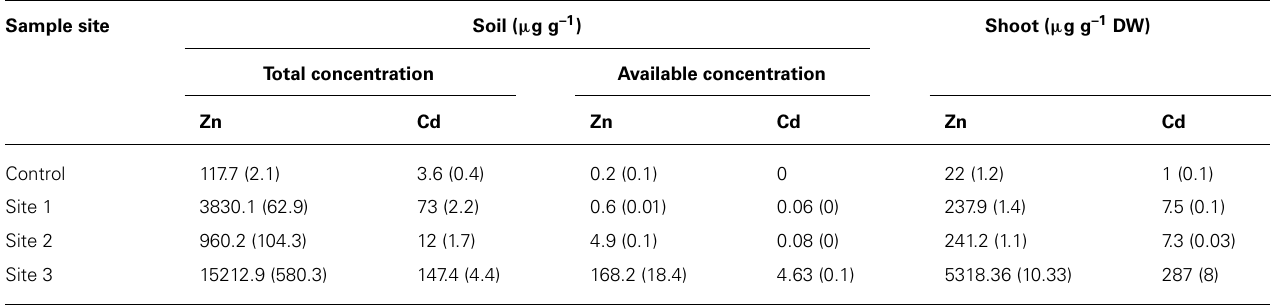
Table 1 | Zinc (Zn) and cadmium (Cd) concentrations ( μ g g –1 ) in soil samples from the Zn smelting area atTrês Marias, MG, Brazil, and in shoots of Gomphrena claussenii plants after growing for 30 days in control and metal contaminated soil collected at four sites around the Zn smelter.